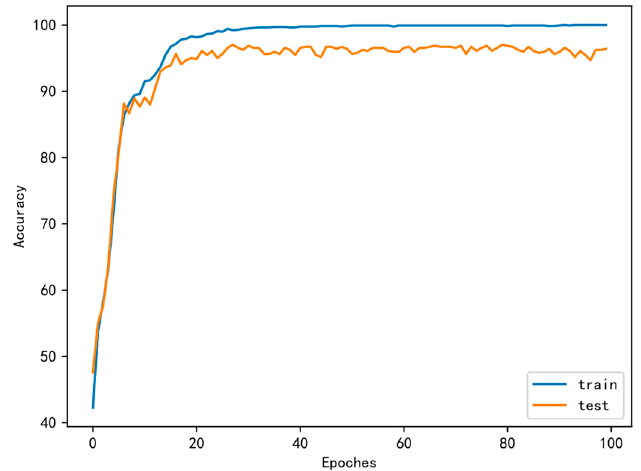
Figure 5. The accuracy of the proposed 1D-CNN model.